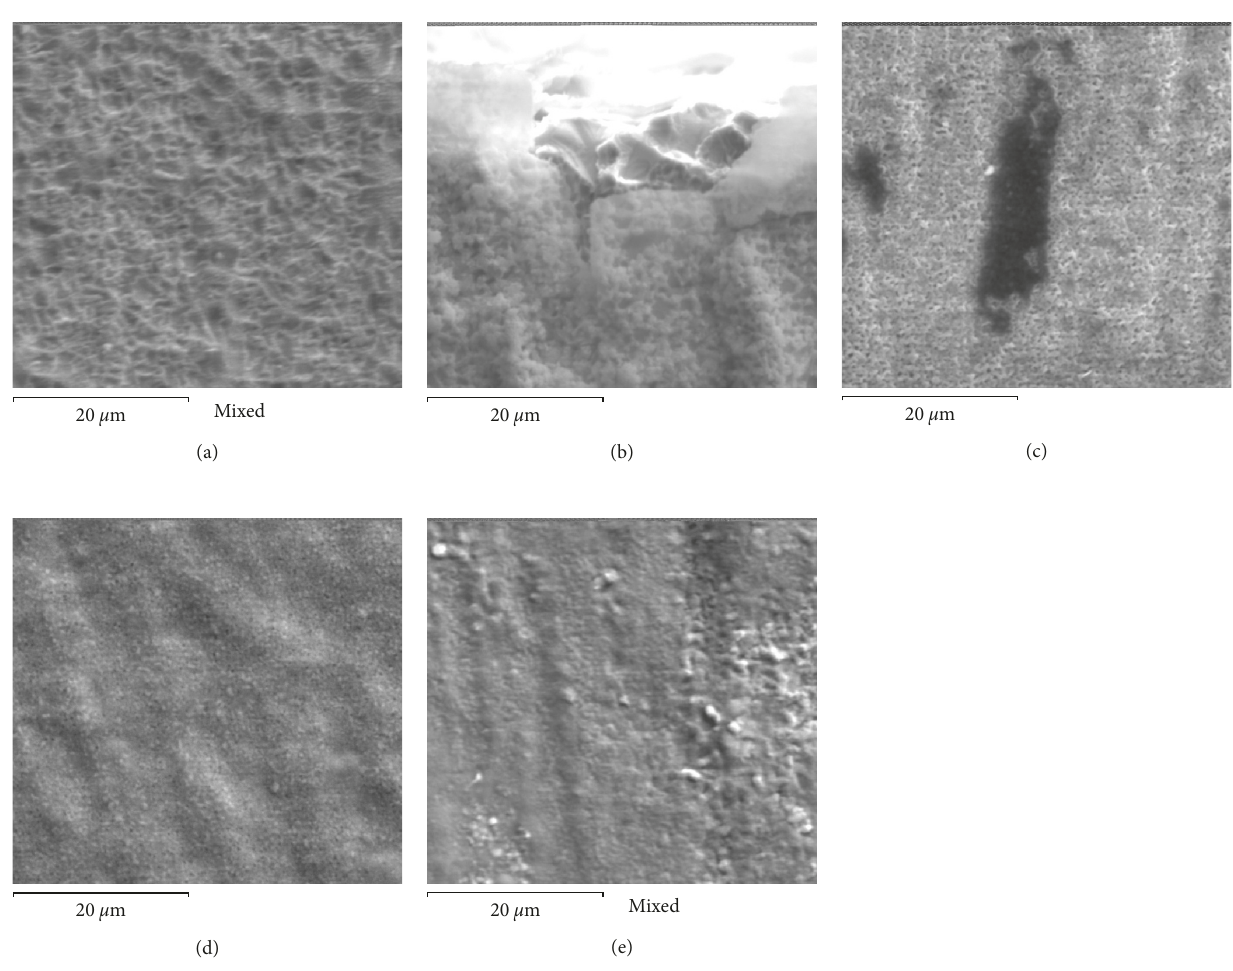
Figure 13: SEM micrographs showing the surface morphology of the oxide scales at 1100 ° C: (a)Ni Au, (d) Ni 3 Al +1.0% Pd, and (e) Ni 3 Al+1.0%